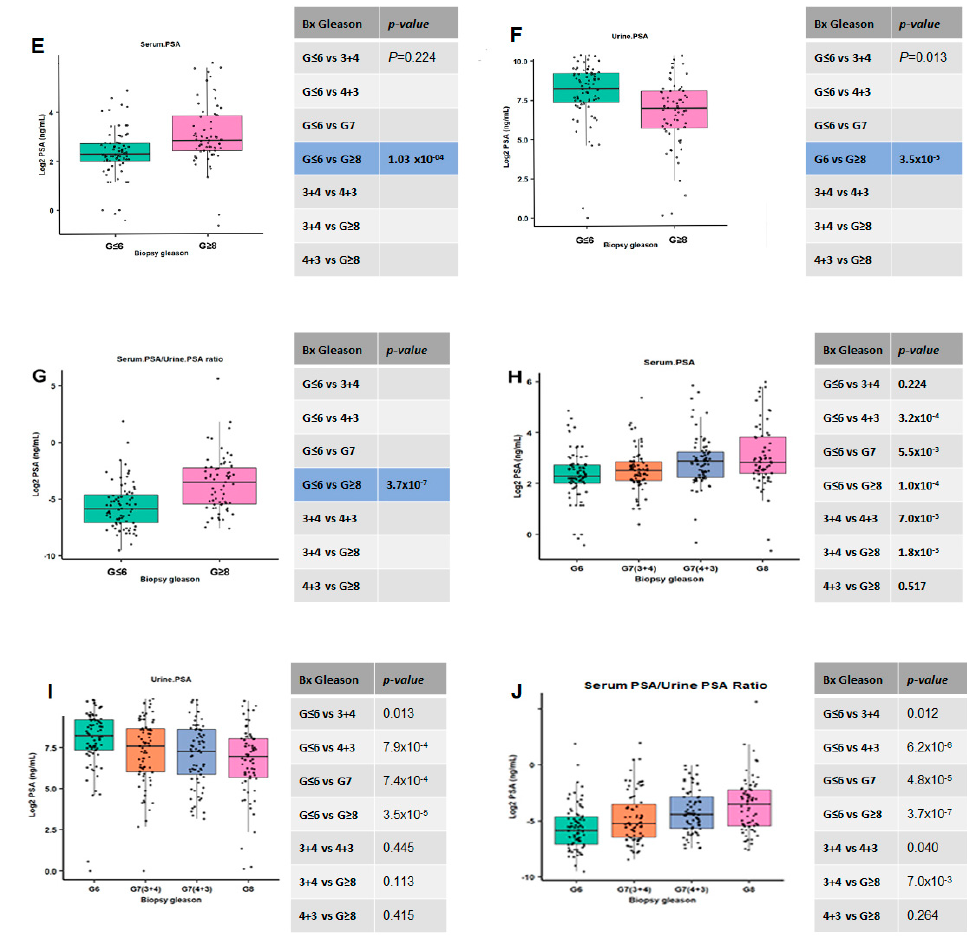
Figure 4. Utility of serum to urine PSA ratio in predicting the biopsy and pathological-based Gleason outcomes: The two-dimensional ellipse plots represent the distribution of PSA values in urine ( x -axis) and serum ( y -axis) for the biopsy ( A ) and radical prostatectomy ( B ) in GS ≤ 6 vs. GS ≥ 8 samples ( A , B ). The ellipse plots show four different ellipse distributions of Gleason scores (GS 6, 3 + 4, 4 + 3, and 8 > ) for surgical or pathological Gleason ( C , D ). The box and whisker plots showing the median PSA values and the overall dispersion of individual PSA values for serum ( E ) or urine ( F ), as well as their respective ratios in samples with surgical GS ≤ 6 vs. GS ≥ 8 ( E , F , G ). The box plots were further used to stratify the serum and urine PSA ( H , I ) and the ratio of serum to urine PSA ( J ) across different surgical grades (biopsy), along with their p -values.